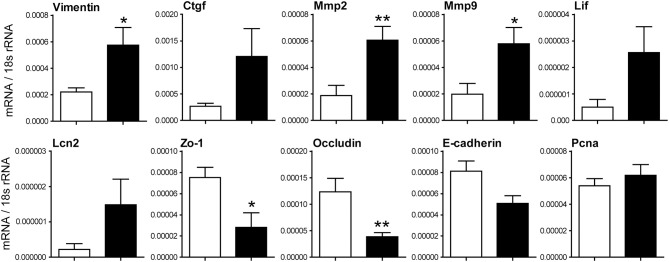
Relative mRNA expression of indicated genes from renal tissues 5 weeks after IRI was normalized per 18S rRNA. mRNA expression of indicated genes was determined from kidney lysates of WT (white bars) and IRF4-deficient mice (black bars). Data are shown as mean ± SEM. *p < 0.05, **p < 0.01.